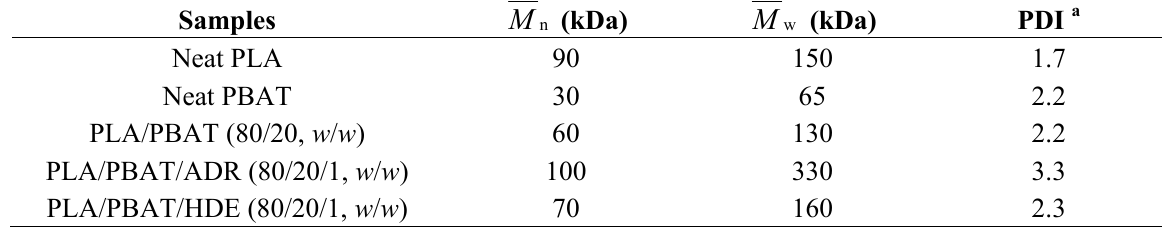
Table 1. Molecular weight analyses of the samples measured via gel permeation chromatography. Samples